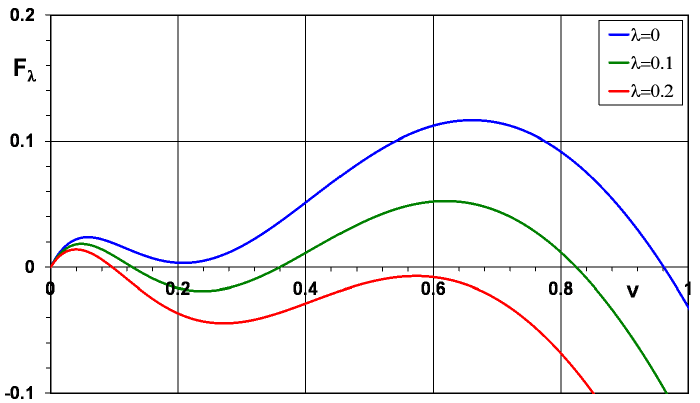
v f ( v )) for λ = 0 (upper curve), λ = 0.1 (middle curve), and λ − − −